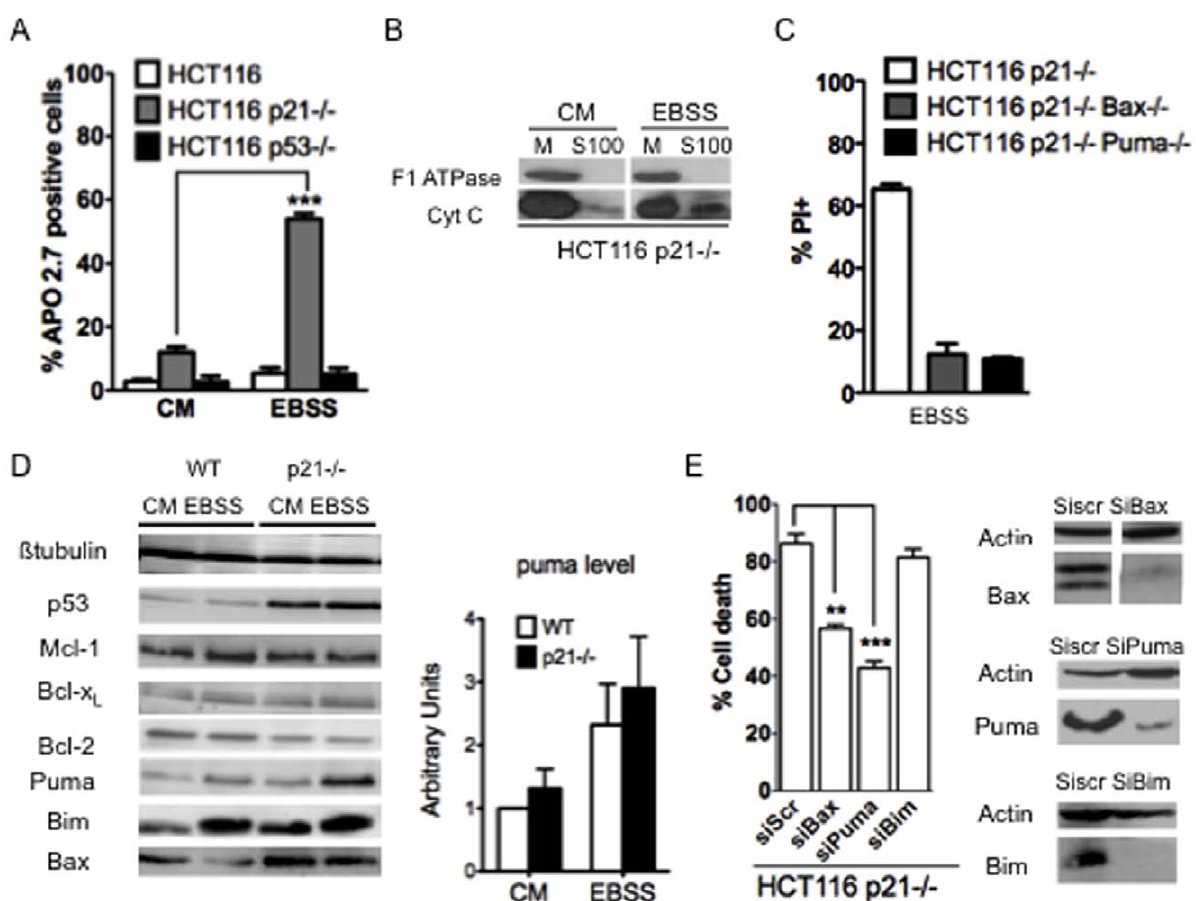
Figure 2. Puma and Bax as key actors of apoptosis induced by starvation in p21-negative HCT116 cells. (A) The indicated cells were placed in complete medium (CM) or in starved medium for 24 h (EBSS). Apoptosis was assayed by APO 2.7 staining using flow cytometry. Data are expressed as a percentage of the total population. (B) Mitochondria (M) and S100 (S100) lysates from HCT116 p21 2 / 2 cells, starved 16 h in EBSS medium (EBSS) or not (CM), were analysed by western blot analysis for F1ATPase and Cytochrome C (Cyt C). (C) Viability of the indicated cells placed under starvation during 24 h was analyzed by PI staining followed by flow cytometry. (D) The indicated cells were placed under complete medium (CM) or in starved medium (EBSS). After 24 h, protein extracts were prepared and the expression of the indicated protein was analysed by western blotting. The amount of Puma was evaluated in each condition by densitometric analysis from three independent experiments and normalized to the amount of Puma level measured in complete medium in wild-type cells (E) The p21 negative HCT116 cells were transfected with the indicated siRNA. 48 h later, cells were starved in EBSS medium for 24 h. Western blot analysis of Bax, Puma and Bim was performed and cell death was assayed by a trypan blue-staining. Data presented in (A), (C) and (E) are mean 6 SEM of three independent